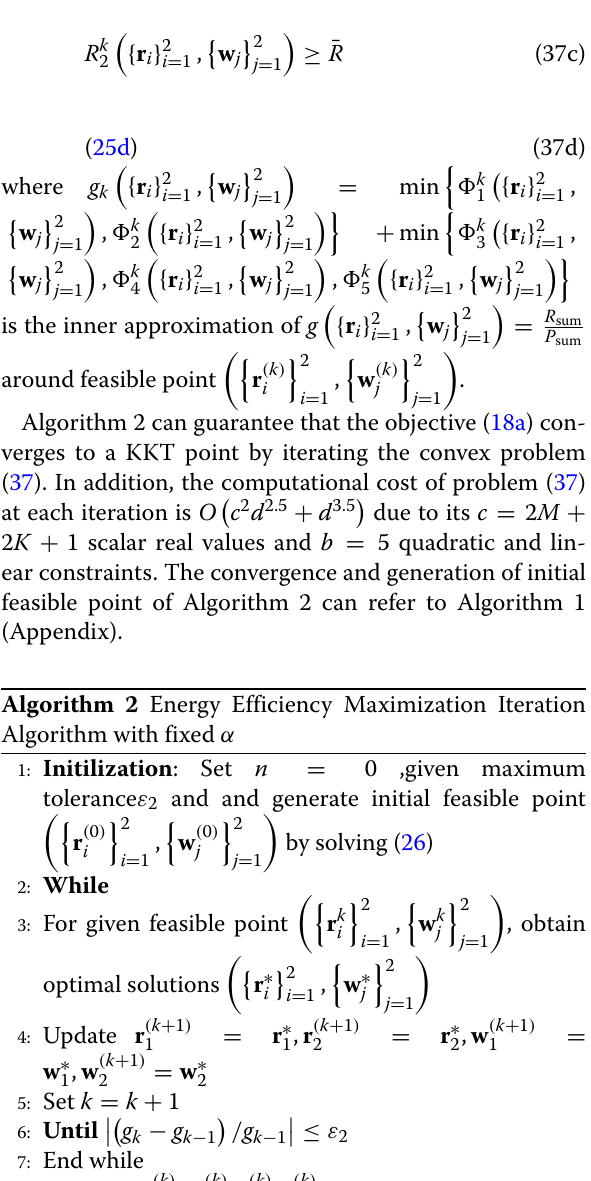
optimal solutions